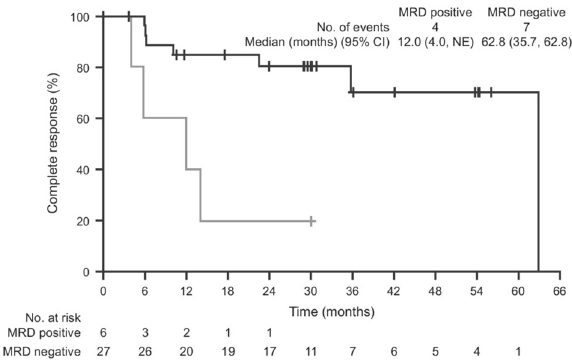
Fig. 1 Achievement of MRD negative status by MFC after moxetumomab was associated with prolonged CR duration (Adapted from Kreitman R, et al, J Hematol Oncol, 2021). MRD negativity was associated with durable